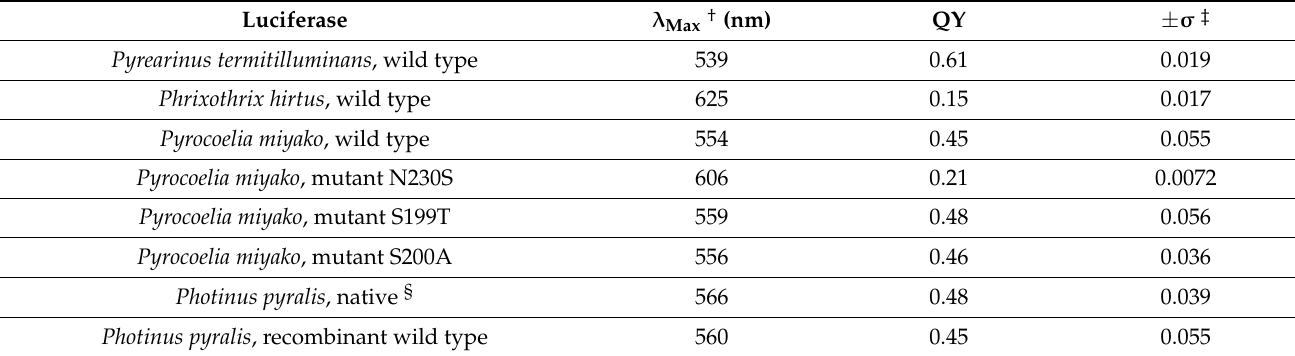
Table 1. Luminescence maxima and QYs for beetle